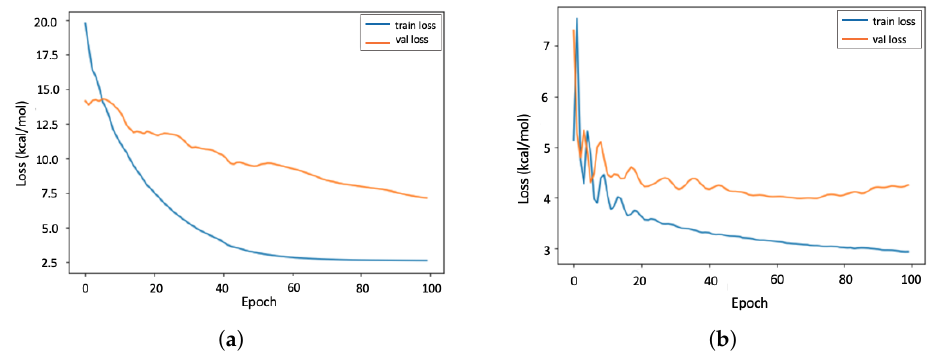
Figure 4. Validation loss (val loss) and training loss (train loss) per epoch for the GraphConv model (data-driven) and the PGNN model (hybrid) on the host–guest dataset. ( a ) GraphConv model; ( b ) PGNN